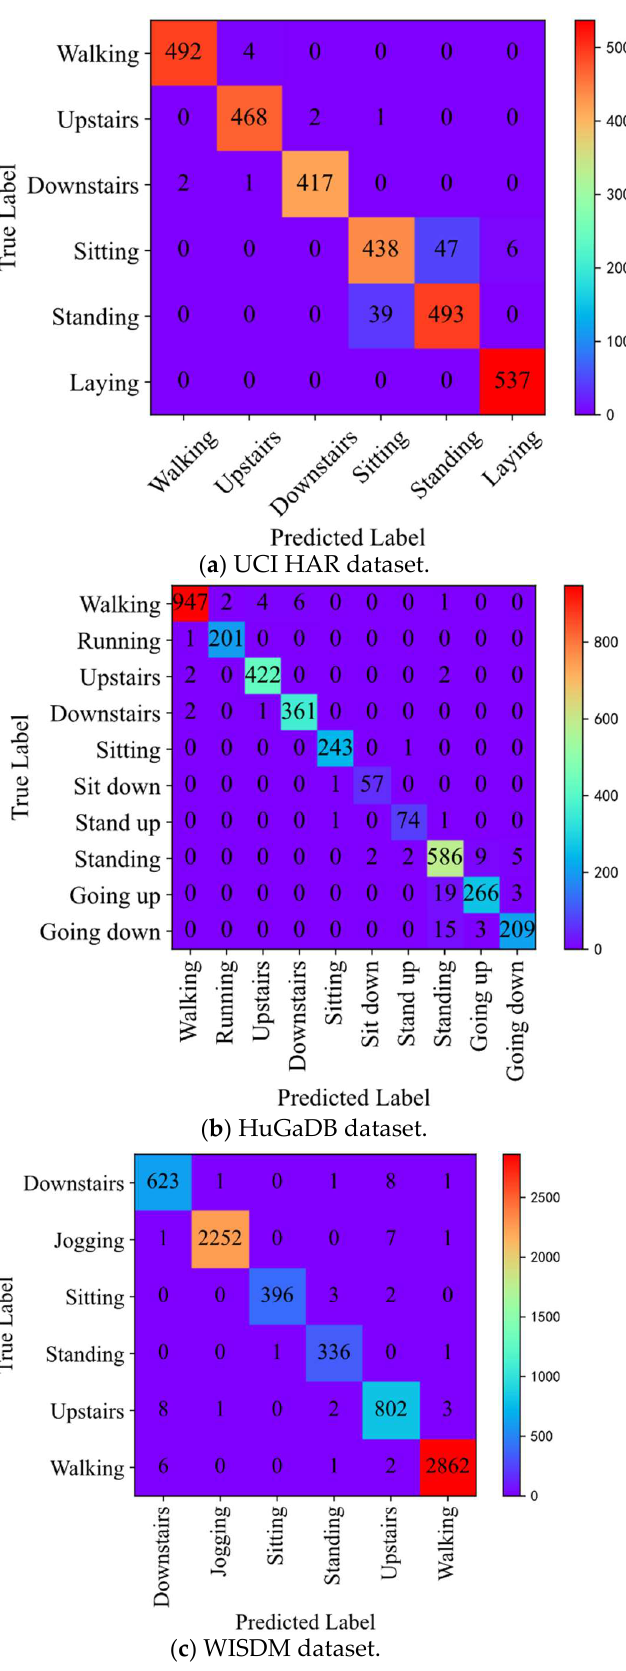
Figure 8. Confusion matrices for UCI HAR ( a ), HuGaDB ( b ), and WISDM ( c ) datasets.